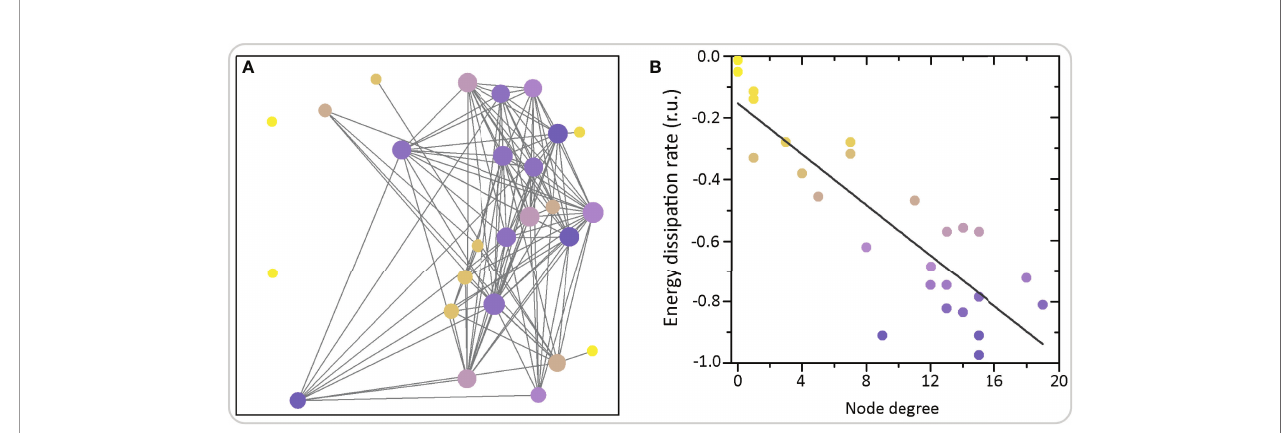
FIGURE 7 | Functional network architecture of beta cells and the corresponding energy dissipation rates. (A) Each circle represents the physical position of a cell inside the islet and the connections signify functional connections. Colors of circles denote the average dissipation rates calculated as the sum of Lyapunov exponents (see Ref (167). for further details). (B) The average dissipation rate re fl ecting the rate of energy consumption of individual cells as a function of the node degree, i.e., number of functional connections. The grey line denotes the linearly decreasing trend showing that highly connected nodes exhibit higher dissipation and energy consumption